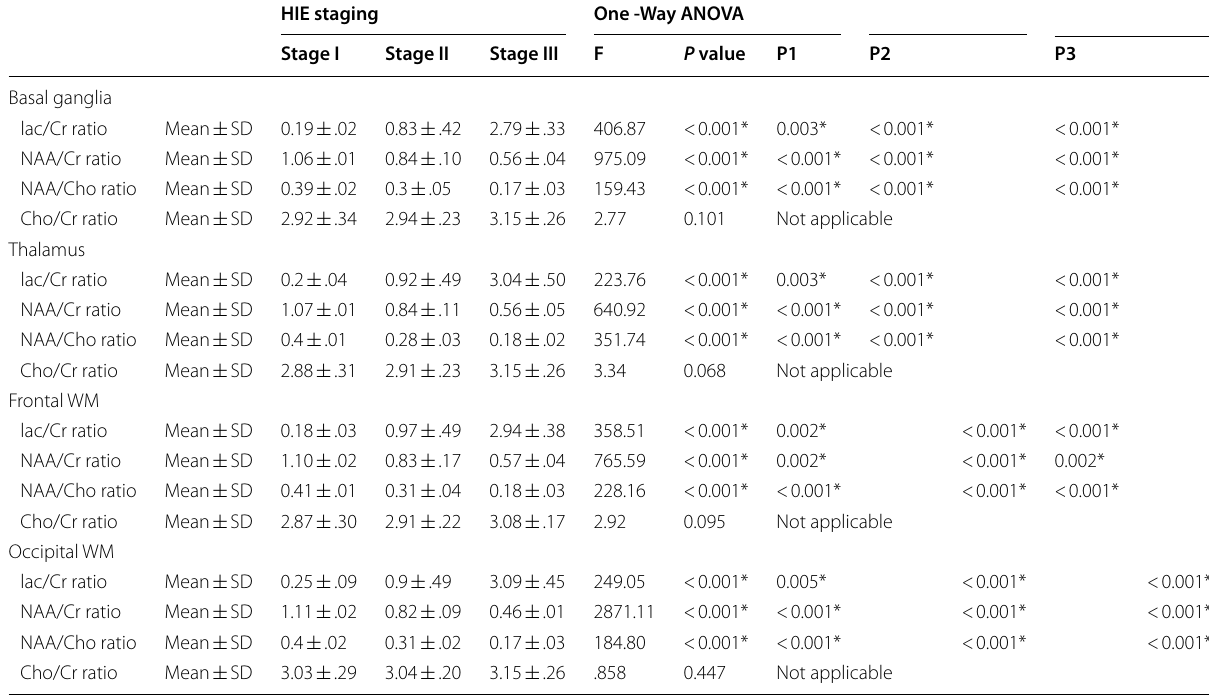
* Significant at p <